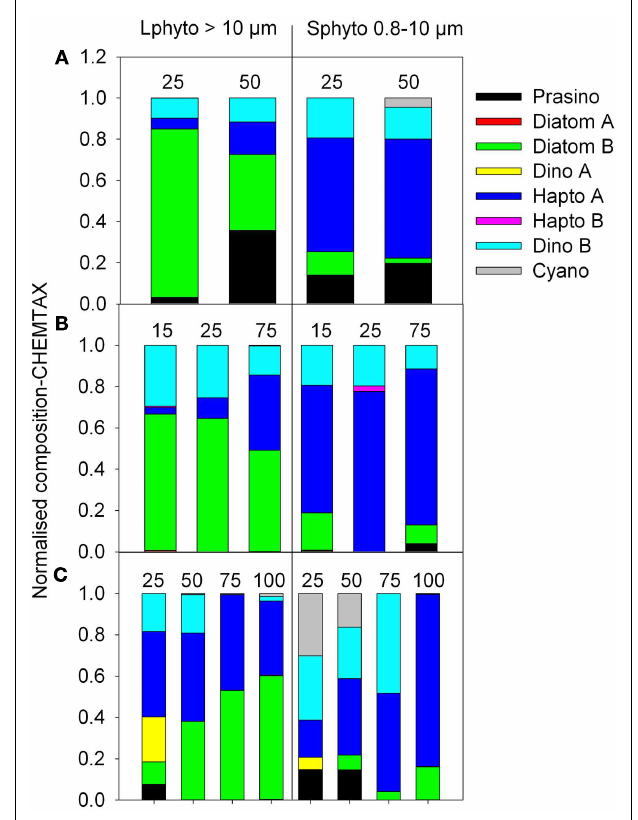
FIGURE 9 | Estimation of the phytoplankton community using CHEMTAX per de Salas et al. (2011). The major groups composing the small (S, 0.8–10 µ m) and large (L, > 10 µ m) phytoplankton communities are represented in percent (stacked bars) at different depths for stations in the